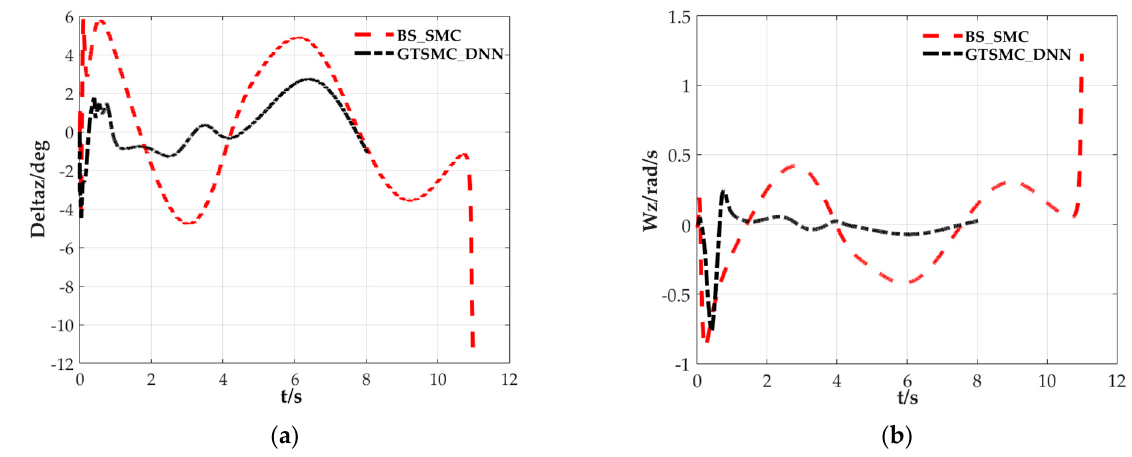
δ angle; ( b ) System states of z